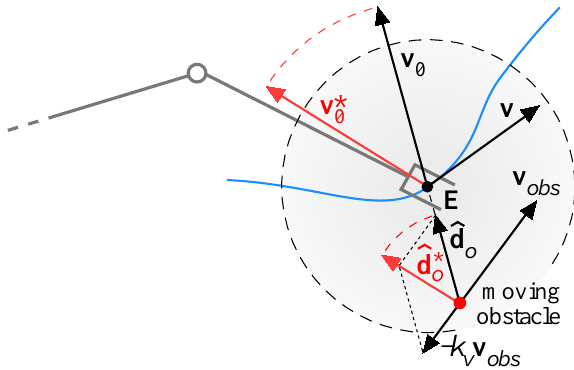
Figure 8. Modified repulsive